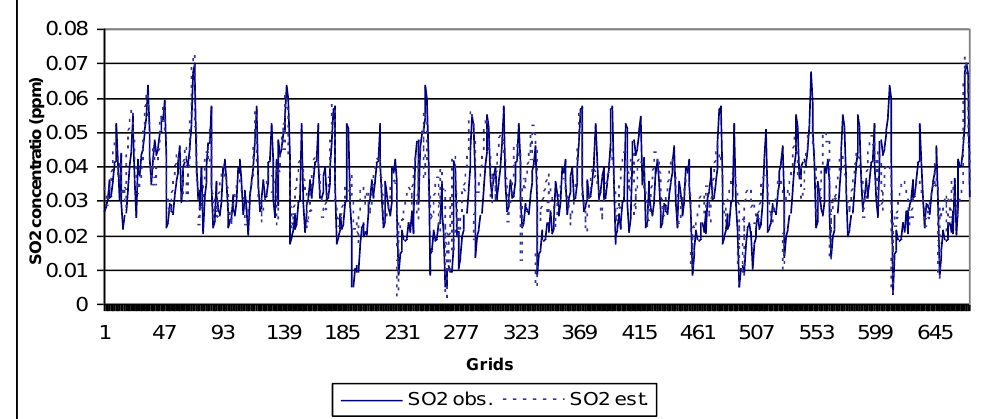
Figure 3. Comparison between SO